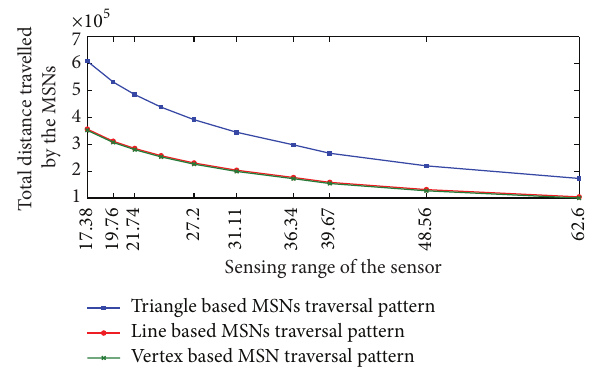
Figure 8: Total distance traveled by MSNs in triangle, line, and vertex based